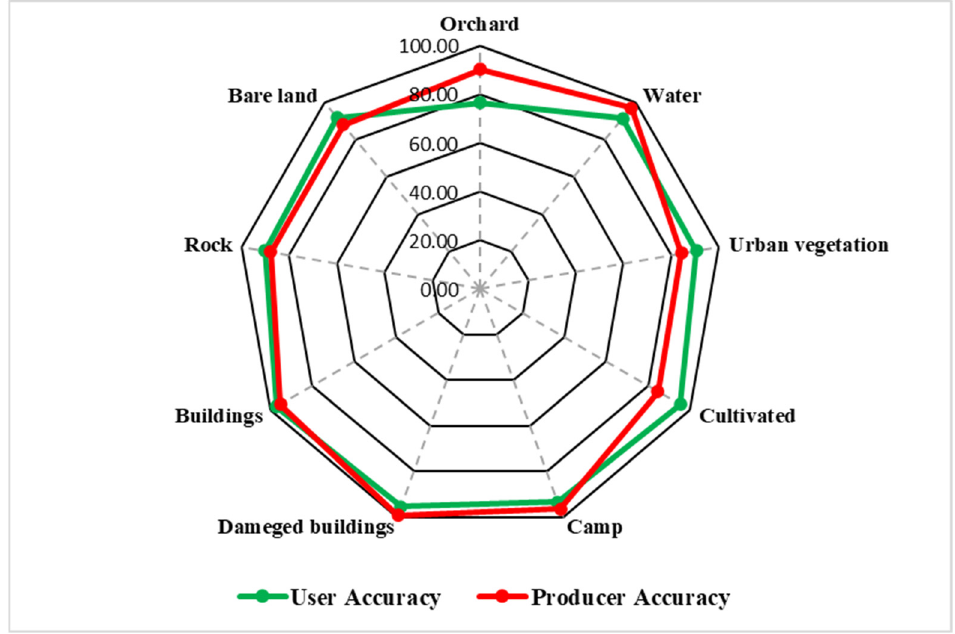
Figure 10. User and producer accuracy assessment for each class.